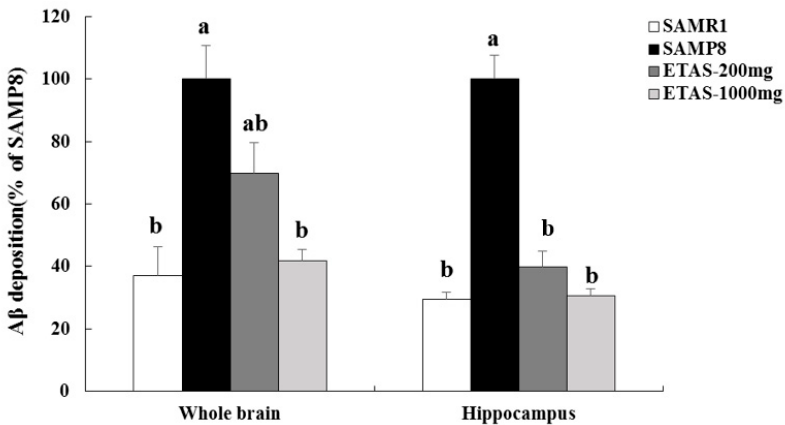
Figure 3. BACE-1 expressions in the cortex and hippocampus of 3-month-old male mice fed with a di ff erent diet for 12 weeks. ( A ) Electrophoretograms of BACE-1 and β -actin expressions. ( B ) BACE-1 expressions of di ff erent groups. The y axis denotes the percentage of each group compared to SAMP8 control group. Values were mean ± S.E.M. (n = 8 / group). Data with di ff erent superscripts are significantly di ff erent among groups.